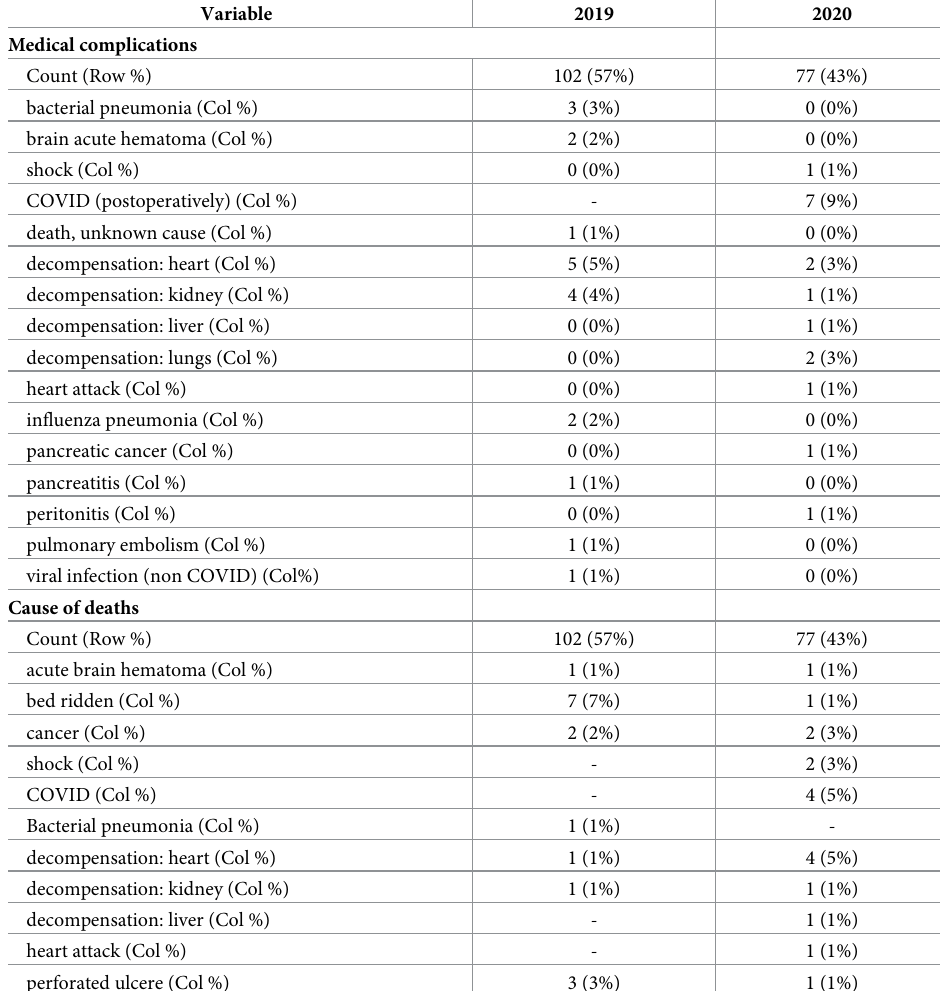
Table 2. Medical decompensations and cause of